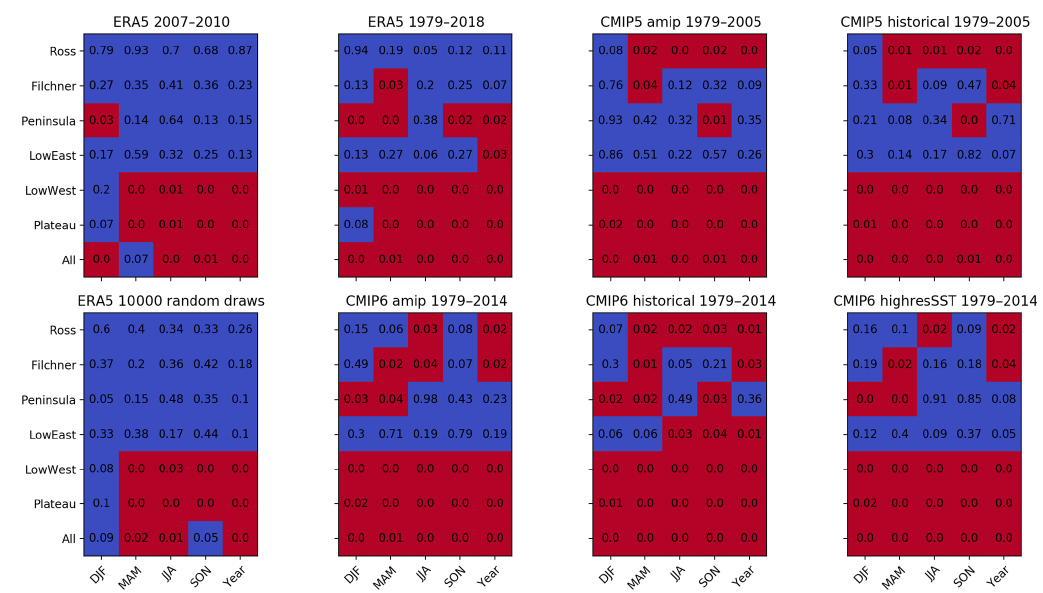
Figure D2. The p values of the Welch t test comparing the snowfall means from CloudSat to ERA5 and each of the CMIP (5 and 6) experiments for various seasons and the whole year in each of the regions considered, considering the whole temporal coverage. Blue color indicates that the p value is greater then the 0 . 05 threshold (null hypothesis can not be rejected); red color indicates that the p value is lower than the threshold (null hypothesis